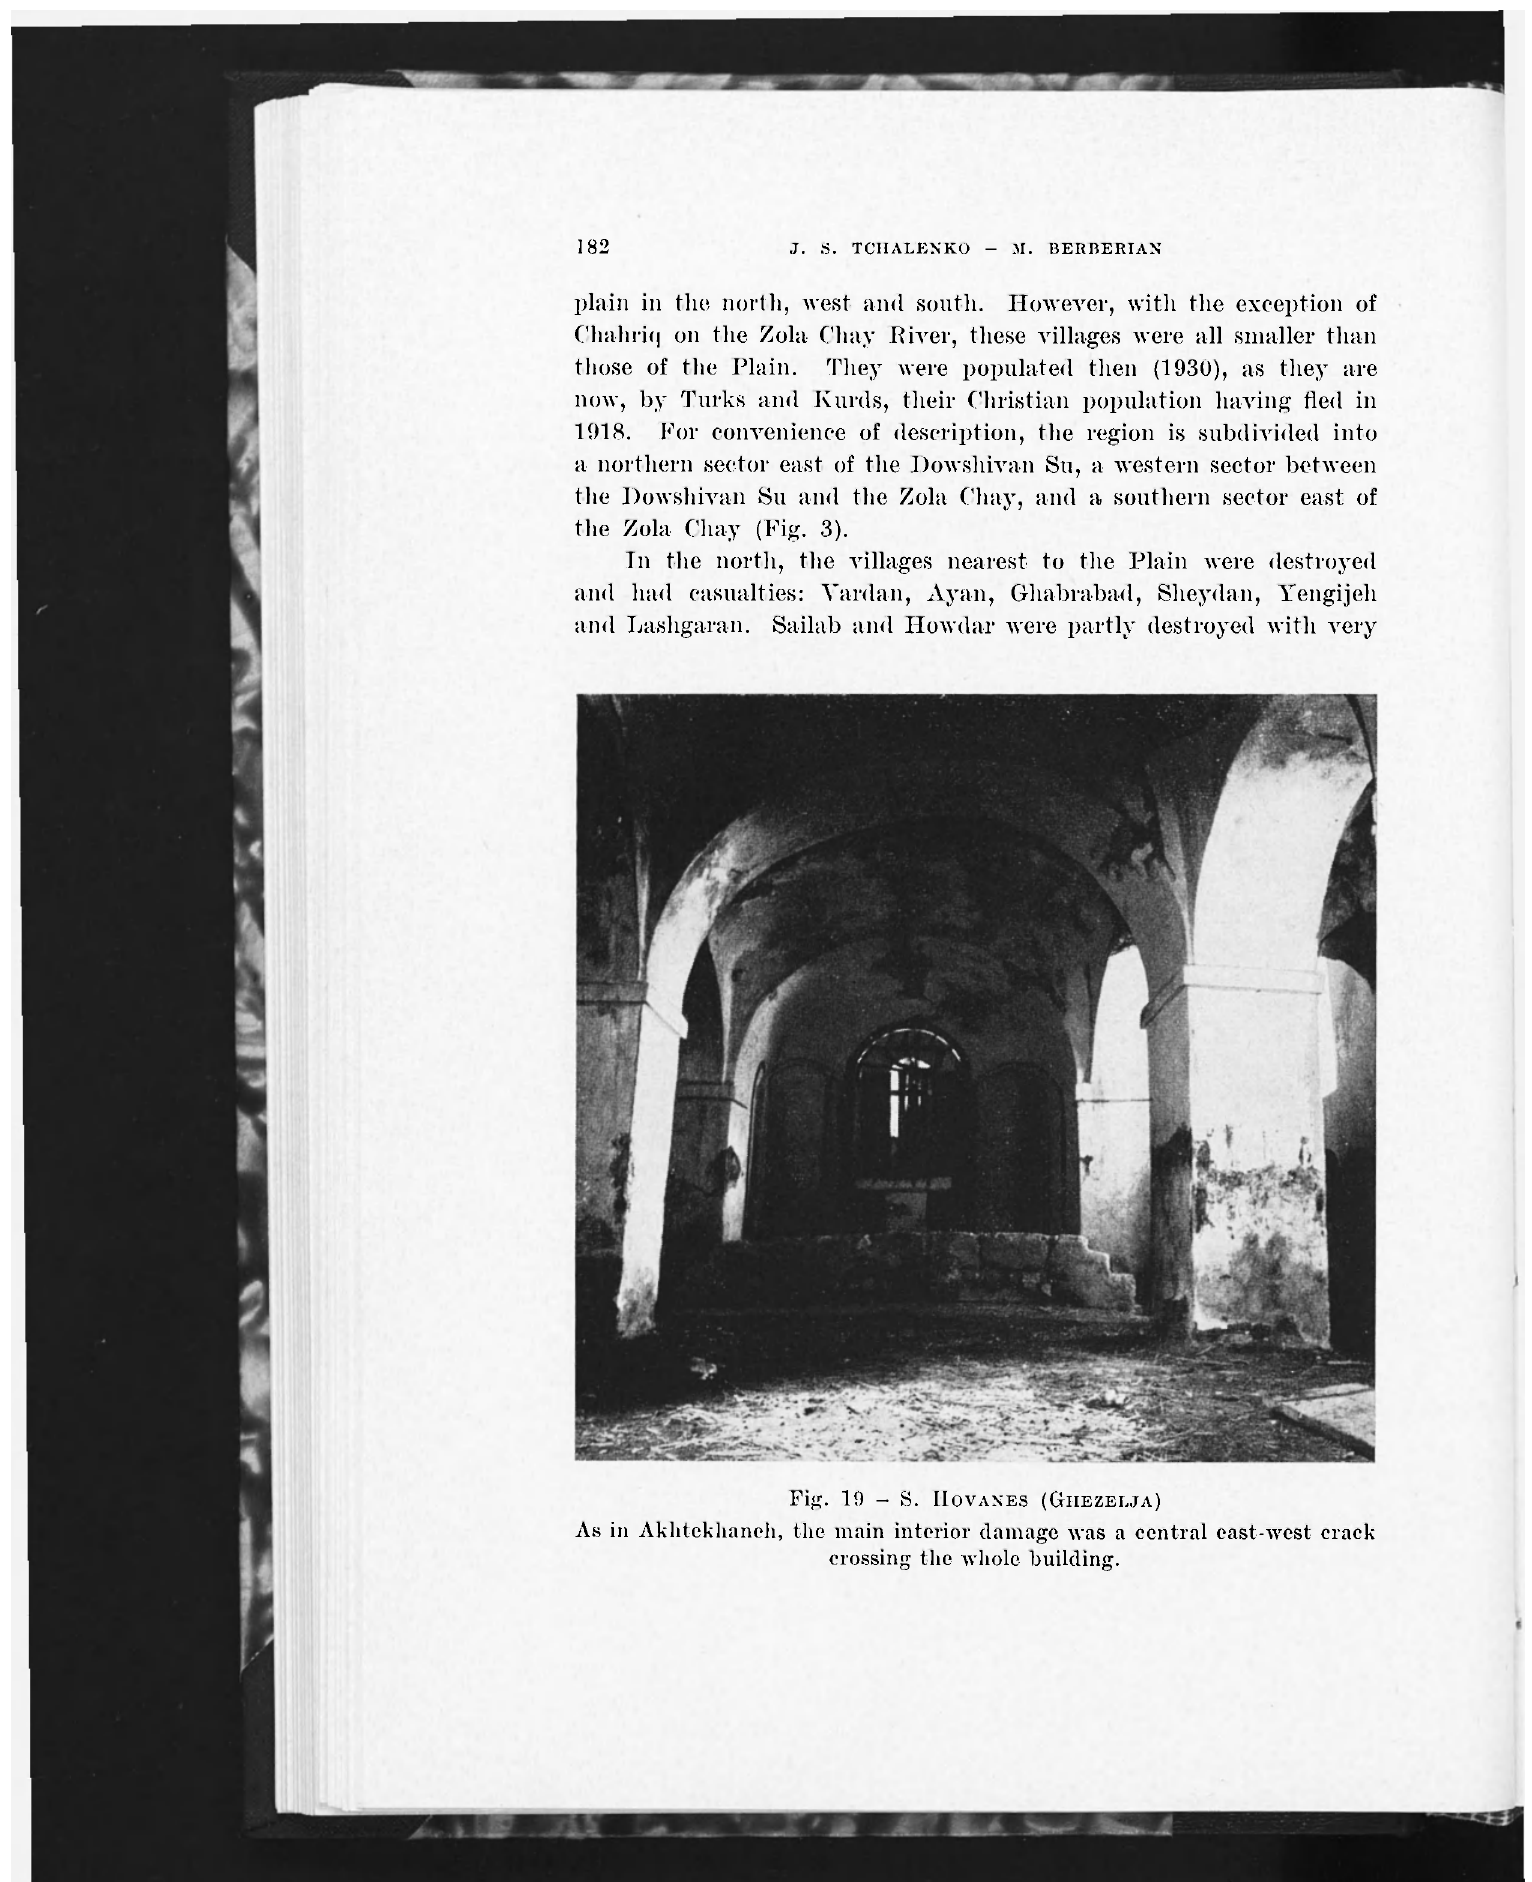
Fig. 19 - S. I-IOVANES